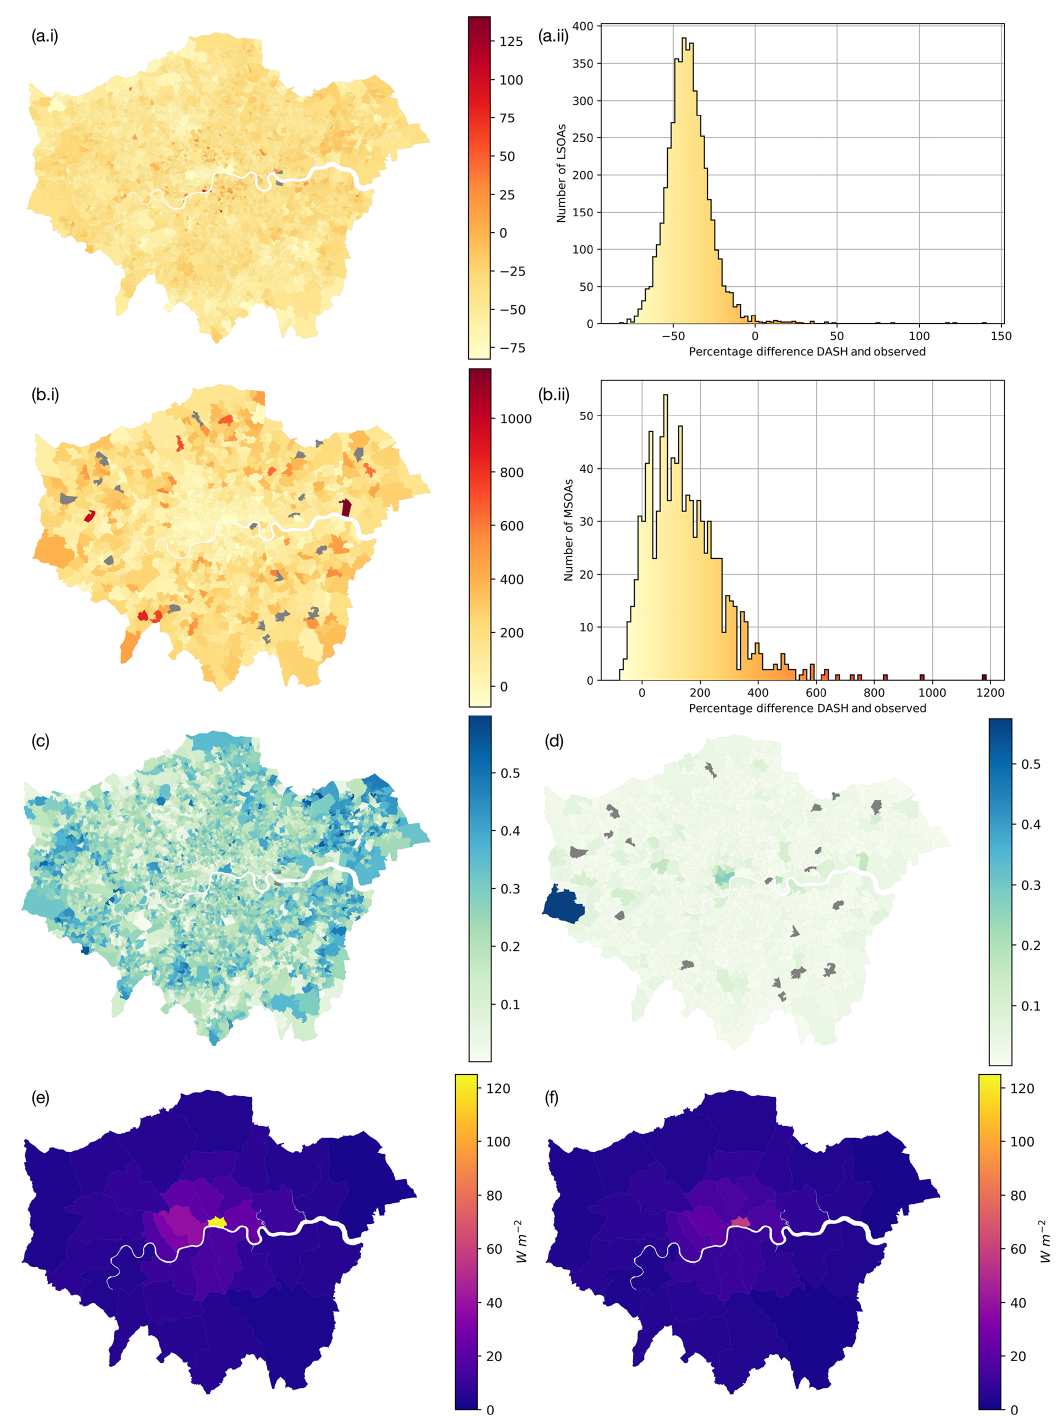
Figure 11. DASH (R8, Table 6) nE i of total energy consumption represented by (i) choropleth and (ii) histogram for (a) LSOA-scale domestic use and (b) MSOA-scale commercial use. AnE i of total energy consumption for (c) LSOA-scale domestic and (d ) MSOA-scale commercial. Annual average energy flux at LA scale for (e) reference data and (f)